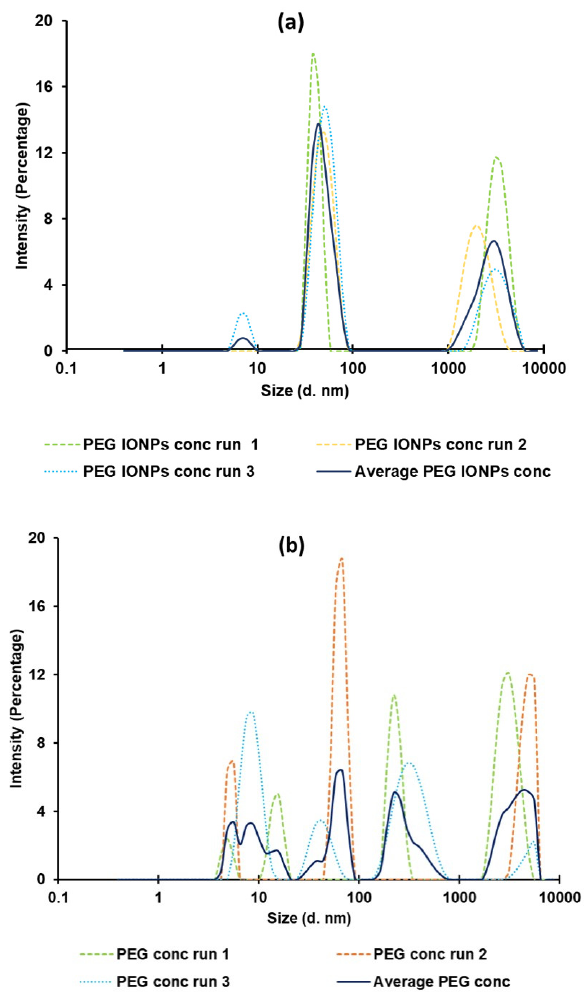
Figure 5. Dynamic light scattering of concentrated PEG IONPs solution ( a ) and concentrated PEG solution ( b ), as control. Averaged signal as well as individual runs are depicted.